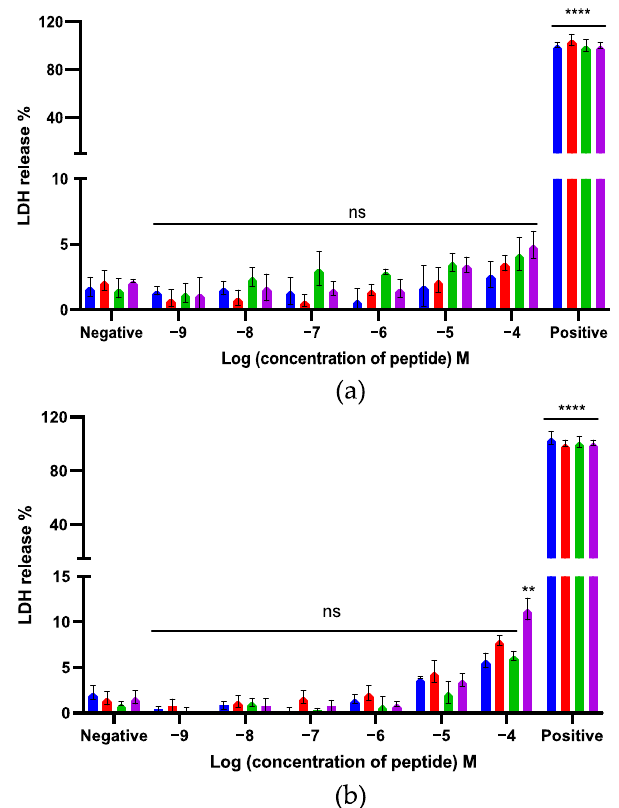
Figure 9. The LDH release of kunitzin-OV 2 (blue), F9-KOV 2 (red), TAT-KOV 2 (green), and TAT-F9- KOV 2 (purple) from ( a ) human microvascular endothelial (HMEC-1) and ( b ) human lung fibroblast (MRC-5) cell lines. HMEC-1 and MRC-5 cells were treated with different peptides for 24 h. Cells treated with 1 × lysis buffer and serum free medium were regarded as the positive and negative controls, respectively. The percentage of LDH release was calculated based on the maximum LDH release rate induced by the lysis buffer in the LDH experimental kit. The error bar represents the SEM of nine replications in three experiments and the significant differences were calculated by comparing different sample groups with the negative control (** p < 0.01, **** p < 0.0001, ns: No significance).